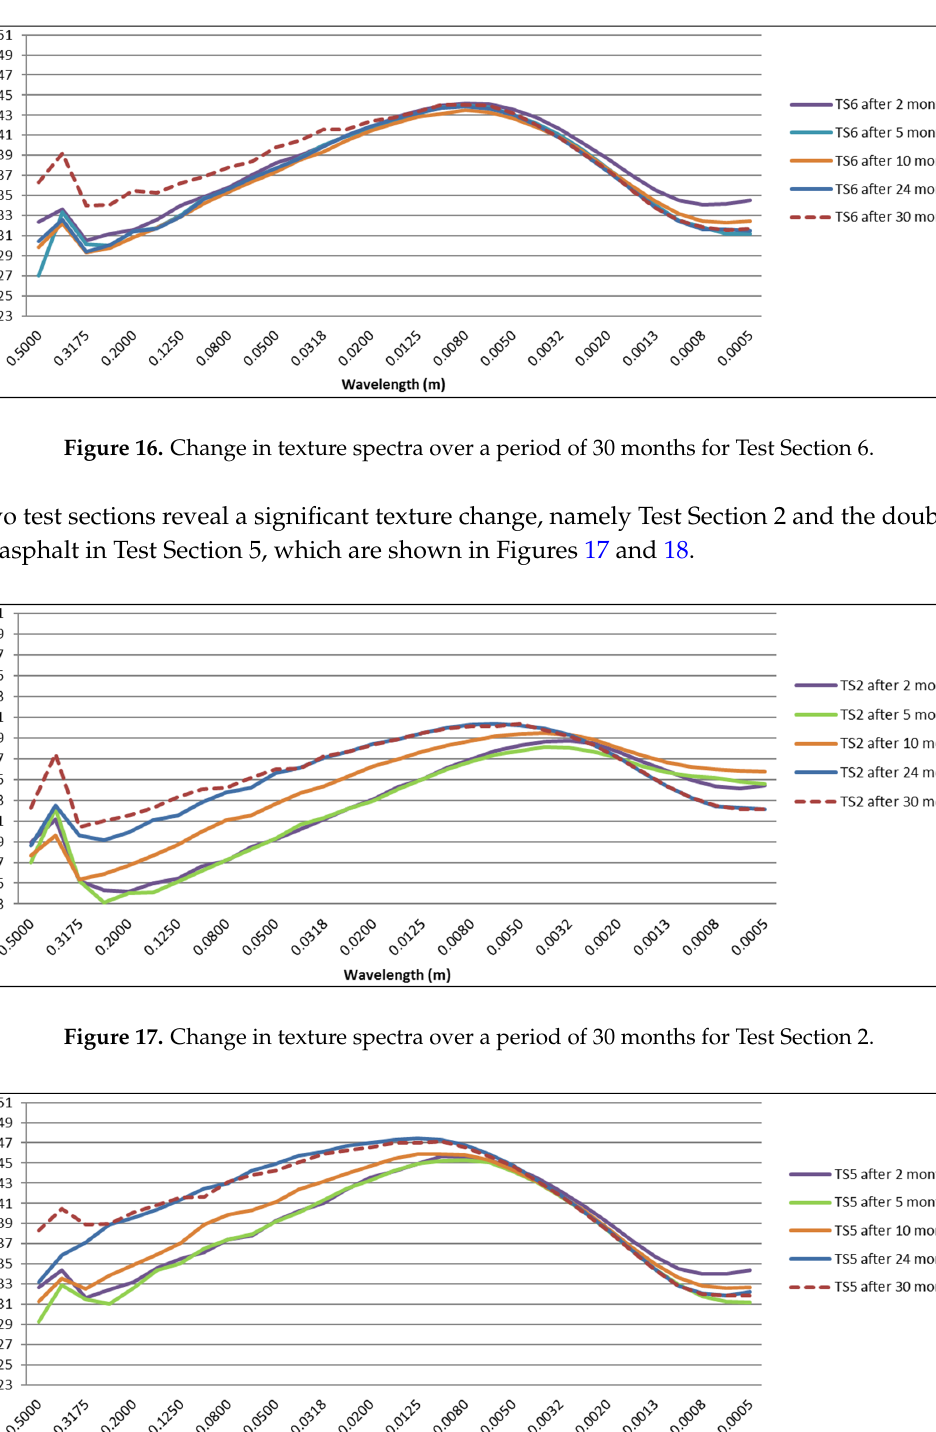
Figure 18. Change in texture spectra over a period of 30 months for Test Section 5 (DPAC).